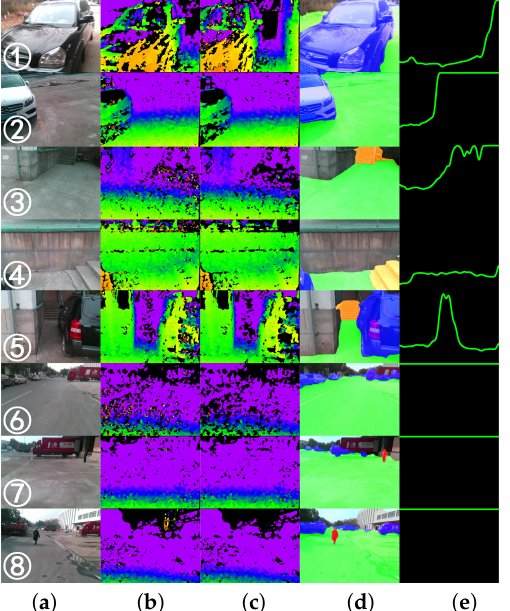
Figure 11. Qualitative examples of detection results and traversable lines produced by our approach in the real-world scenario of the field test, corresponding to the locations marked in Figure 10: ( a ) RGB image, ( b ) original depth image; ( c ) depth image with noise reduction; ( d ) segmentation result and ( e ) traversable